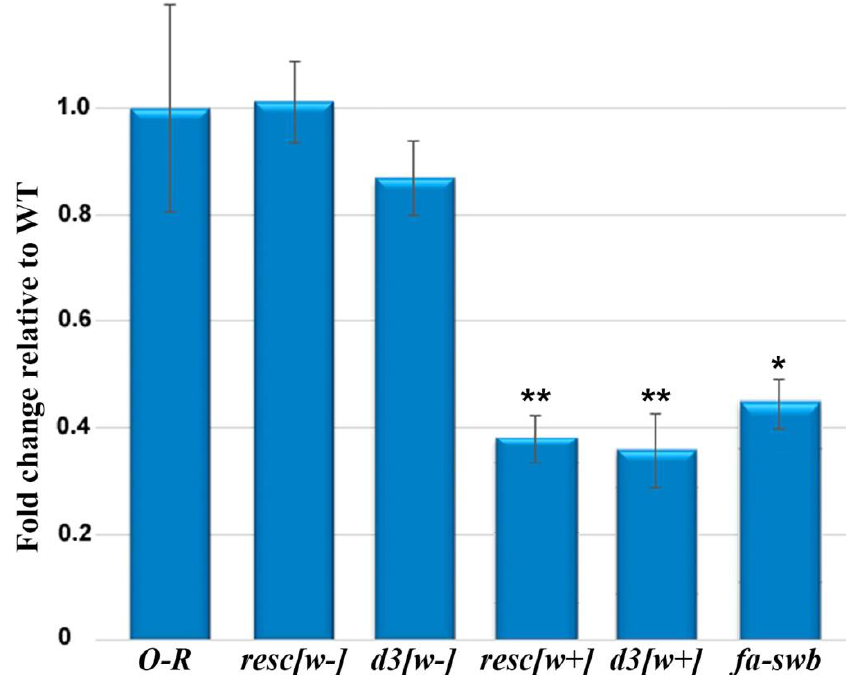
Figure 3. Transcription of the Notch gene as measured by RT-qPCR in wild-type and mutant ova- ries of imago females. The Zfrp8 gene was used for normalization as an endogenous control. Error bars represent standard error of the mean from three replicates ( n = 3). To evaluate the significance of differences between samples, Student’s t test was performed ( n = 3). * p < 0.05, ** p < 0.01.